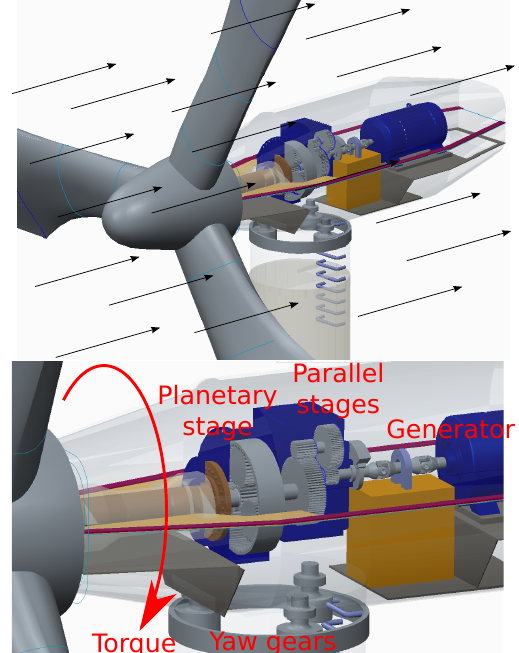
Figure 1: Wind turbine subject to a given wind (cid:28)eld with illustration of main shaft torque, driving the carrier and planets in the gearbox, for generating power through the